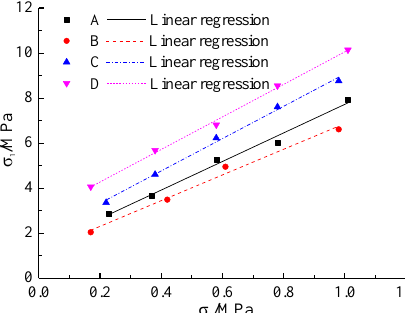
Figure 9. Variations of the triaxial compression strength with the confining pressure of briquettes of different particle sizes.